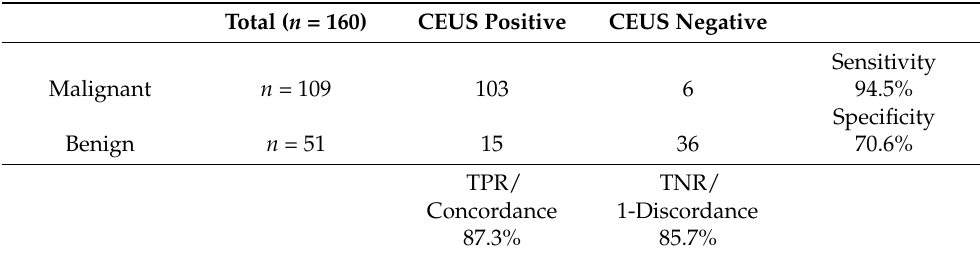
Table 2. Distribution positive and negative results from CEUS among malignant and benign focal liver lesions determined by histopathology.